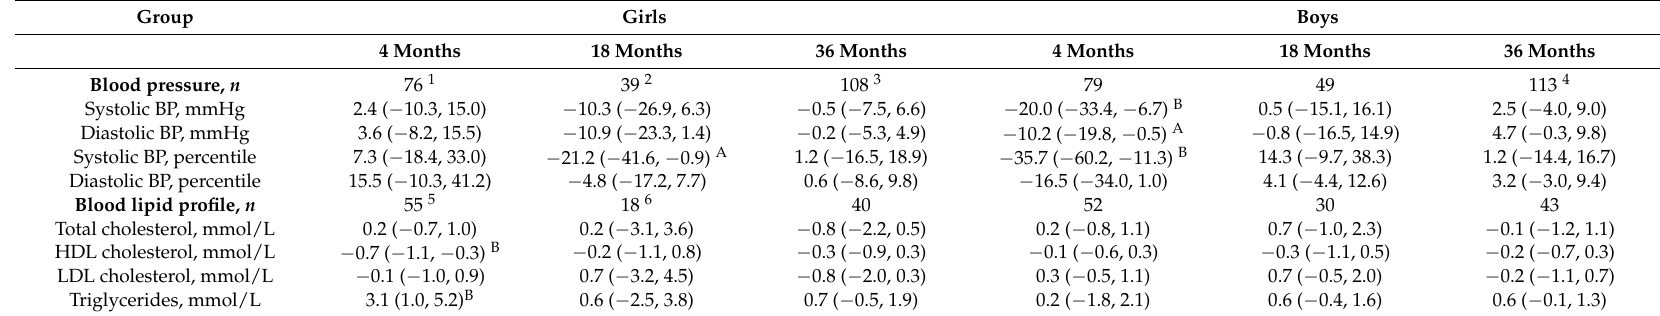
Table 4. Cross sectional associations between breast milk total n-3 LC-PUFA content and blood pressure and blood lipid profile. Values presented are β (95% CI) for n-3 LC-PUFA (wt%) as exposure and outcome as indicated per